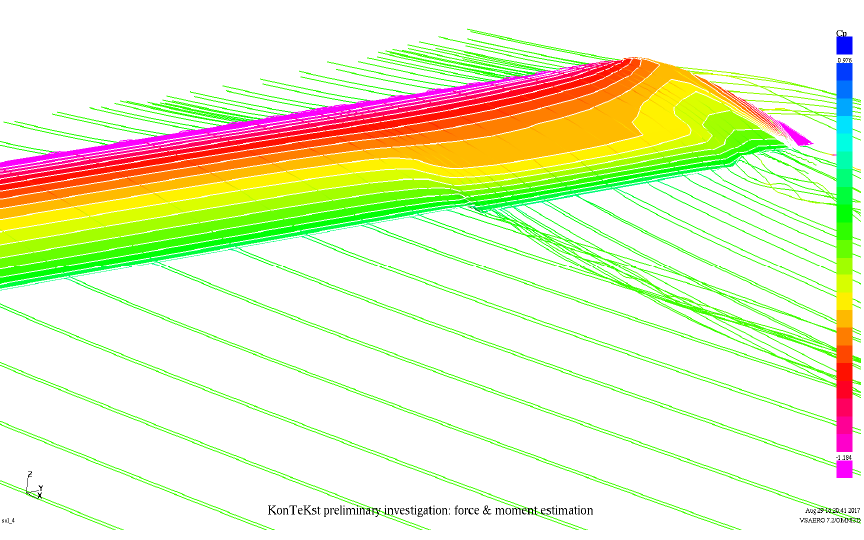
Figure 4. VSAERO model including a trailing edge flap ranging from y = 1.2 to 1.5 m.